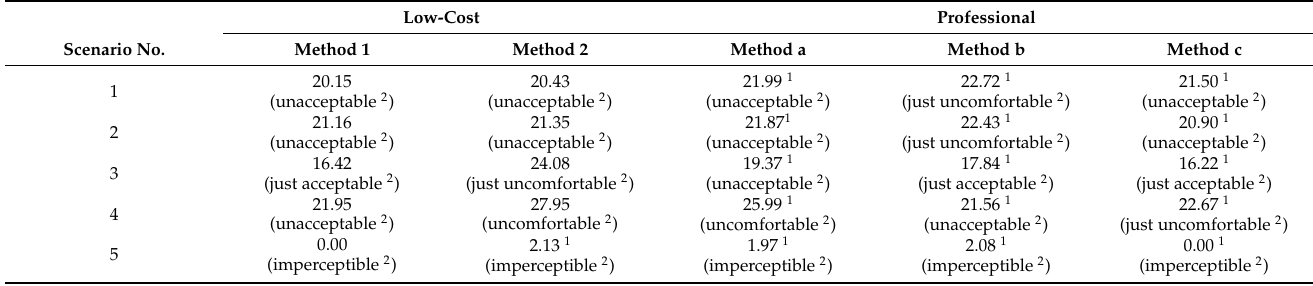
Table 4. UGR values for the different scenarios and related sensation based on a 9-point